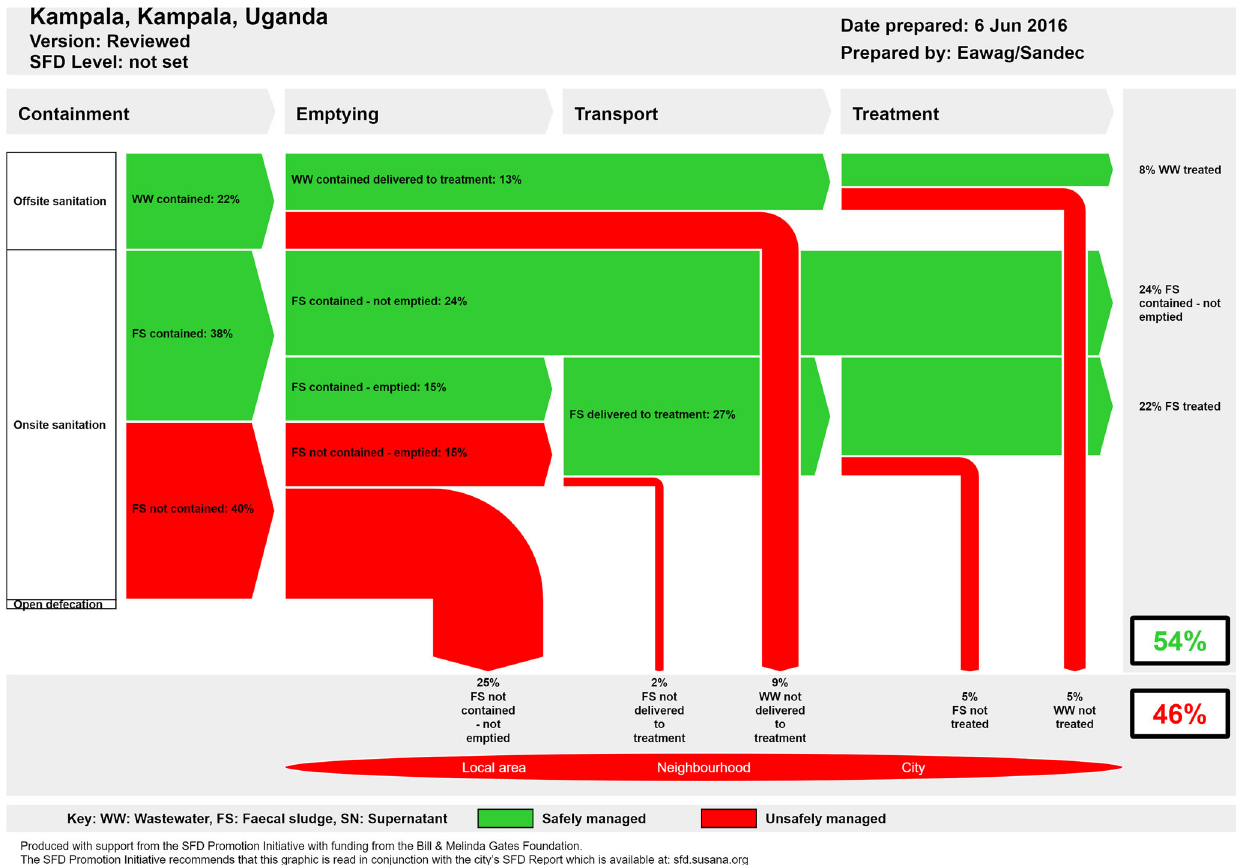
Fig. 1 Excreta fl ow diagram (SFD) for Kampala (from Schoebitz et al. 14 ). Aggregated faecal fl ows that are safely separated (green) and not safely separated (red) from human contact at the containment, emptying, transport and treatment stages of urban sanitation as a proportion of the total faecal waste produced by the population in Kampala, Uganda. The proportion of the population using offsite (sewered) sanitation, on-site sanitation (pits and tanks) and no sanitation (open defecation) is indicated by the size of the relevant division of the white bar on the left. Proportions of faecal waste that subsequently escape into the environment are indicated by the size of the red vertical arrows showing fl ows that enter the local area, neighbourhood or city-level drainage system,